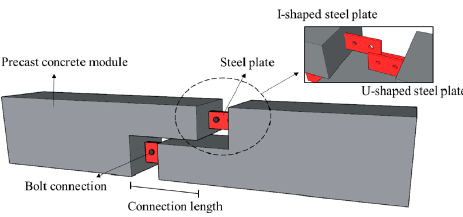
Figure 2. Scheme of proposed precast concrete modular beam system.